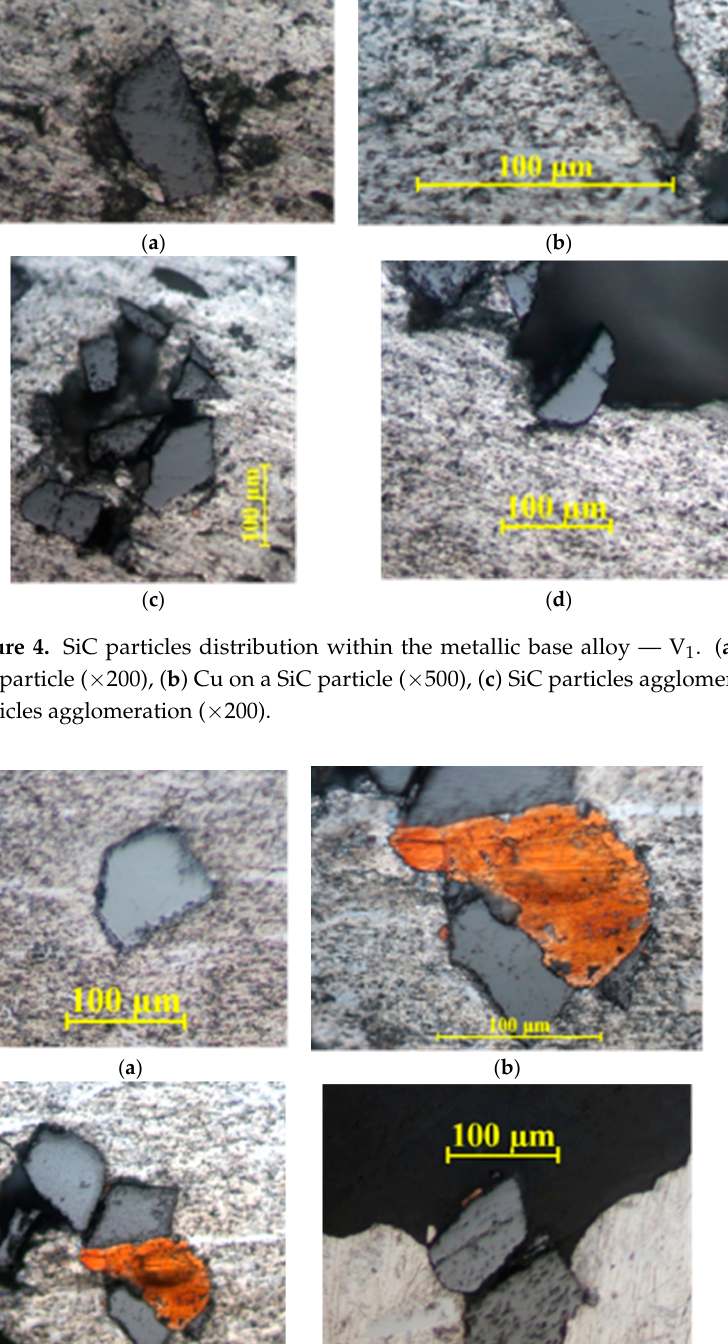
( a ) ( b ) ( c ) Figure 6. SiC distribution in the metallic base — V 3 . ( a ) Central embedded SiC particle (×200), ( b ) SiC particles agglomer ‐ ation (×200), ( c ) SiC particle embedded at sample surface (×200). For the V1 method the SiC particles coated with a thin layer of Cu were preheated at 900 °C and introduced as such in the metallic mass. Due to the preheating stage the parti ‐ cles started to conglomerate and formed lumps that were not crushed afterwards. As a result, the SiC particles were not evenly distributed. Instead, some agglomerations appear in certain areas of the samples (Figure 4c). As an effect of the centrifugal casting, certain agglomerations were dispersed, thus well ‐ embedded single particles also appear in the sample (Figure 4a). The use of activated particles (covered with a thin layer of Cu) is clearly highlighted in Figure 4b where the presence of copper is very well observed. The activated SiC particles show a good adhesion to the metal mass, which is proved by the fact that, although the samples were processed with abrasive paper, the particles were not removed from the surface (Figure 4d).